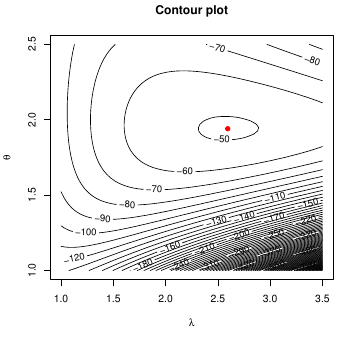
Figure 3 – Contour plot for the real data set 1.